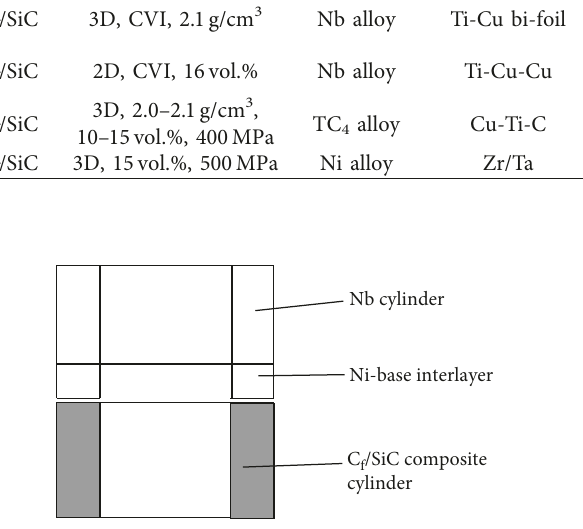
Figure 13: The diagram of specimens before being joined. Figure 14: The diagram of capillary process that filler gets into clearance by action of ultrasonic vibration.